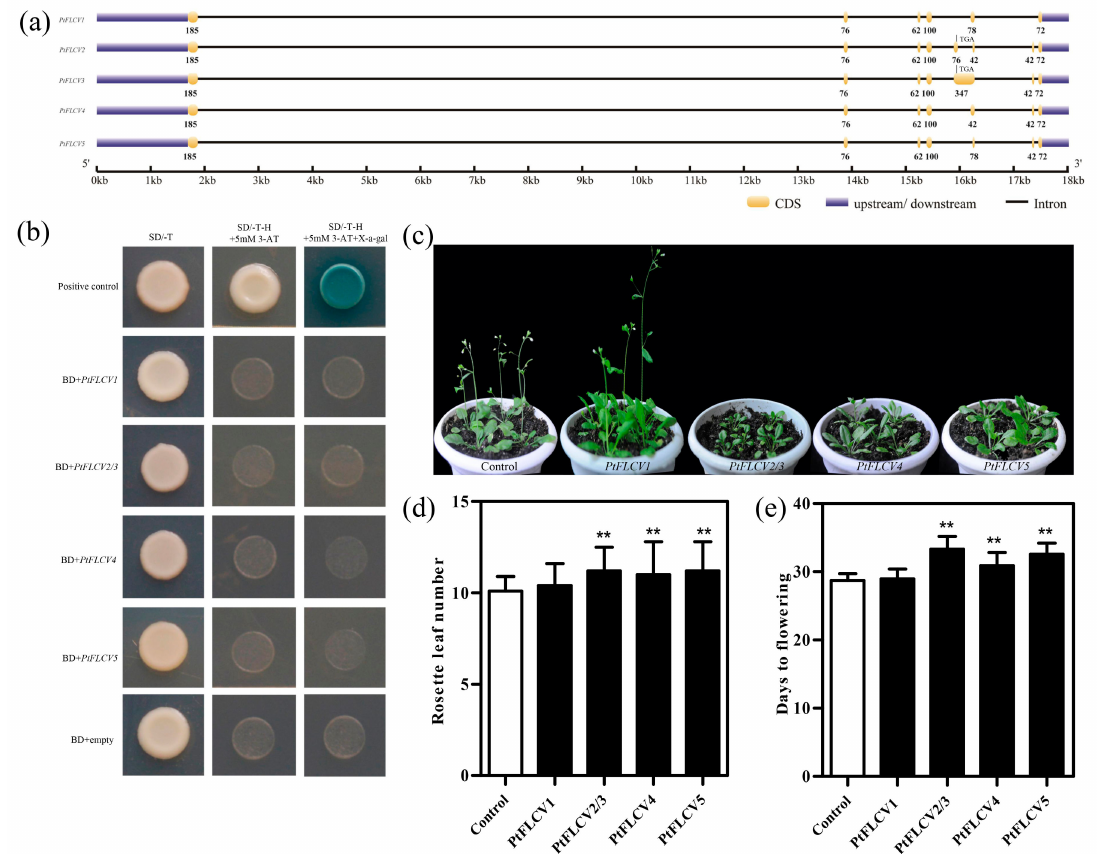
Figure 1. Transcriptional activity and functional analysis of citrus FLOWERING LOCUS C homolog ( PtFLC) . ( a ) Structural comparison of five alternatively spliced PtFLC transcripts, rectangular boxes indicate exons and lines indicate introns. ( b ) Transcriptional activation analysis of five alternatively spliced PtFLC transcripts in yeast cells. Yeast cells carrying pBD-PtFLCV1, pBD-PtFLCV2 / 3, pBD-PtFLCV4, pBD-PtFLCV5, pGBKT7emptyvector(asanegativecontrol), orthepositivecontrol(pCL) were streaked on SD / -Trp / -His medium supplemented with 5-bromo-4-chloro-3-indolyl- α -galactoside (X- α -Gal) and 3-amino-1,2,4-triazole (3-AT). ( c ) Phenotype analysis of PtFLC transgenic Arabidopsis . ( d ) Numbers of leaves and days to flowering of transgenic plants from five PtFLC transcripts at time of flowering stage under long day. Asterisks indicate significant di ff erences (Student’s t -test): ** P <